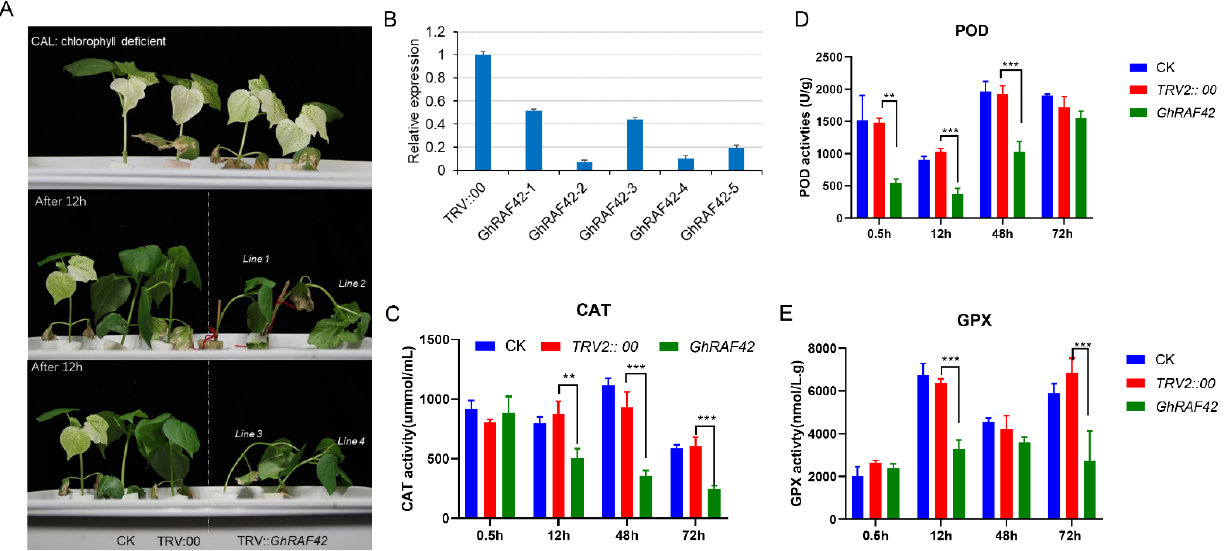
Figure 7. Silencing of GhRAF42 gene by VIGS and enzyme activity (CAT/POD/GPX) analysis under salt stress ( A ) After salt stress, the phenotype of control and gene silenced plants with albino appearance in comparison with CAL: chlorophyll deficient, CK: control, TRV::00: negative control and TRV:: GhRAF42 containing leaves ( B ) Relative expression of 5 cotton plants with silenced gene ( C ) CAT contents in CK: control, TRV2::00 empty vector and TRV2::GhRAF42 candidate gene containing plants. ( D ) POD contents in CK: control, TRV2:00 empty vector and TRV2 = GhRAF42 candidate gene containing plants ( E ) contents in CK: control, TRV2::00 empty vector and TRV2 :: GhRAF42 candidate gene containing plants. The significant differences between transgenic lines and their corresponding control plants is Student ’s t -test; ** p < 0.01; *** p < 0.001.